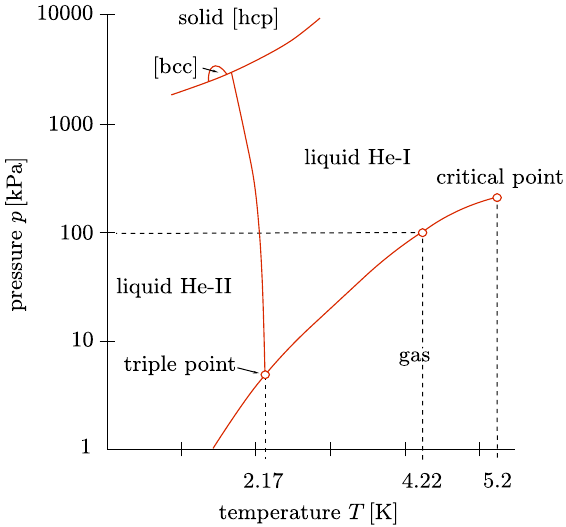
FIG. 1. Helium phase diagram [10]. Cooling down helium under normal pressure the liquid phase occurs at 4.2 K.